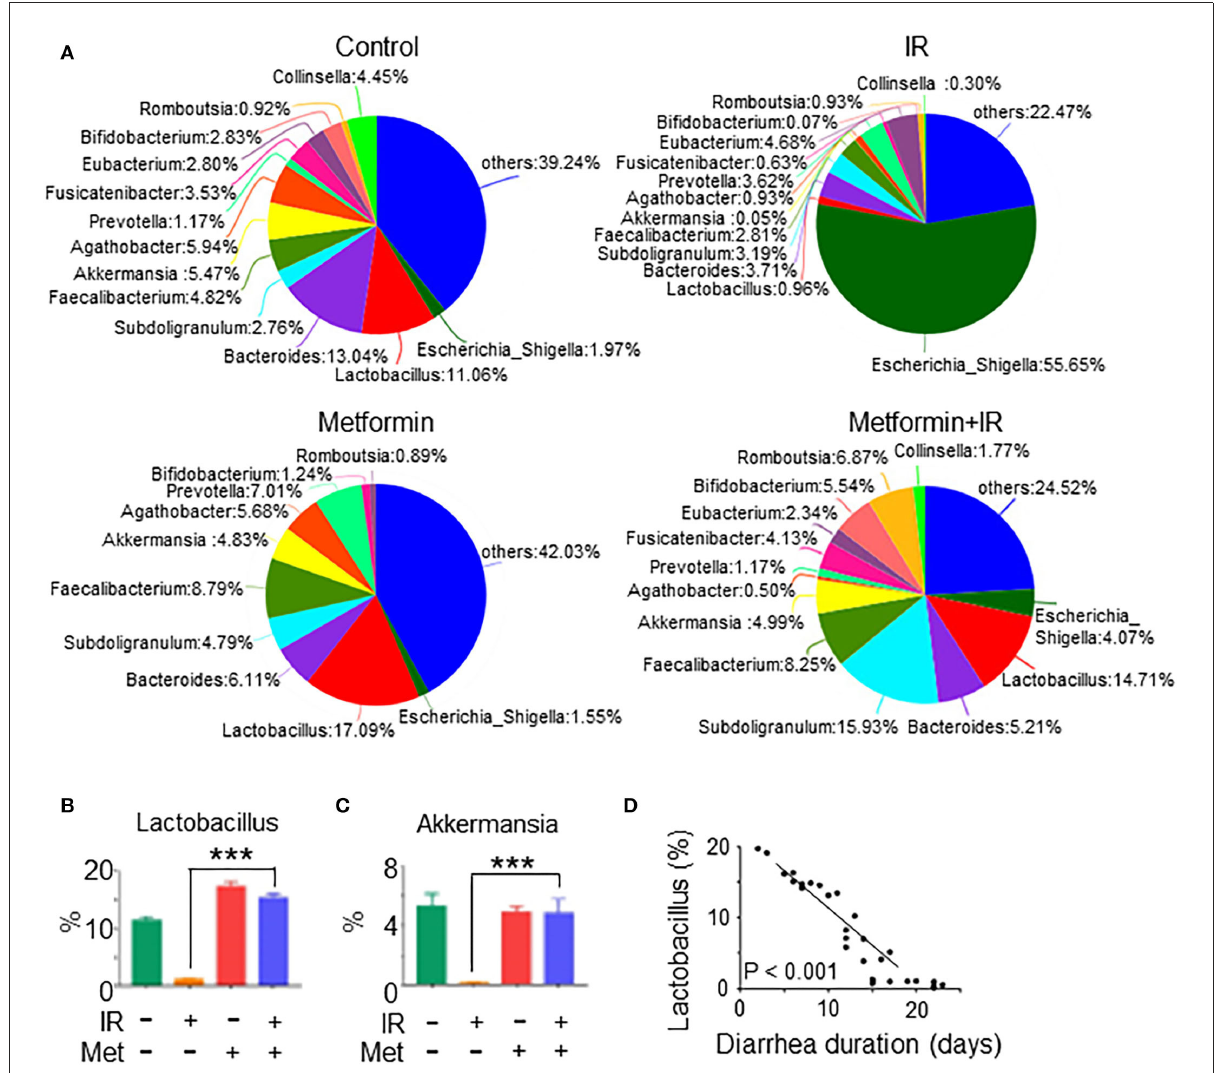
FIGURE8 Metformin improves the composition and abundance of intestinal flora in abdominal IR patients. Feces samples from cervical cancer patients receiving abdominal IR with or without metformin treatment and healthy subjects were collected. Total DNAs were isolated from the feces as described in the Materials and methods section and subjected to 16S rRNA sequencing. (A) Pie analysis of intestinal flora in abdominal IR patients with or without metformin treatment and healthy subjects. (B,C) Percentage of Lactobacillus (B) and Akkermansia (C) in the intestinal flora. (D) Correlation of Lactobacillus abundance and diarrhea duration in abdominal IR patients. Data represent mean ± SEM. *** P < 0.001, compared with abdominal IR patients, n = 15 in each